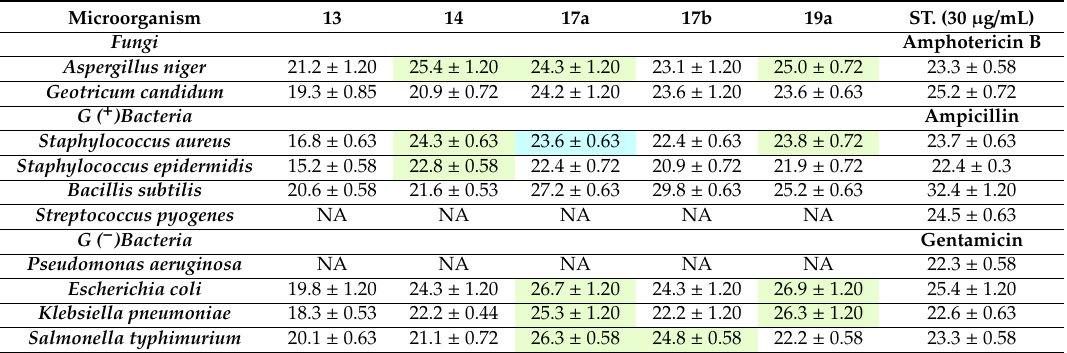
Table 4. Preliminary anti-microbial activity for compounds 13 , 14 , 17a , b and 19a . Table 5. Preliminary anti-microbial activity for compounds 19c – f and 21a . Table 3. Preliminary anti-microbial activity for compounds 2 , 6 – 8 , 12 .